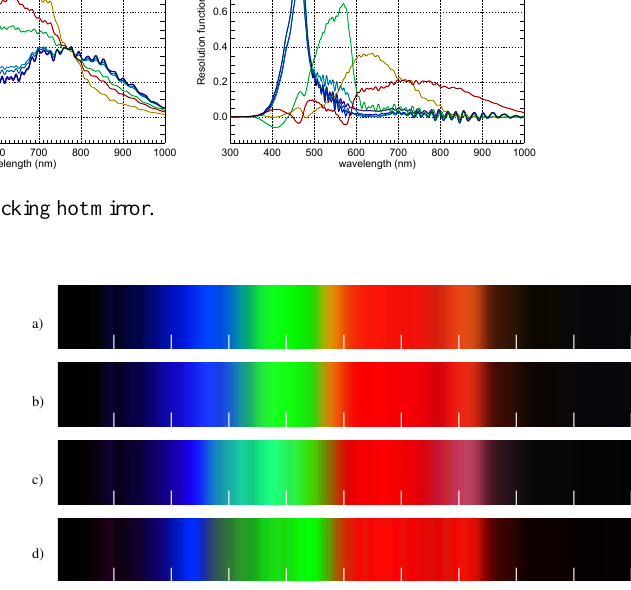
The RGB contribution matrix for the MX7C raw mode is given in Equation 20. There is a similar scale difference reflecting greater CCD sensitivity to red wavelengths and a complex mapping from device channels to primary colors.